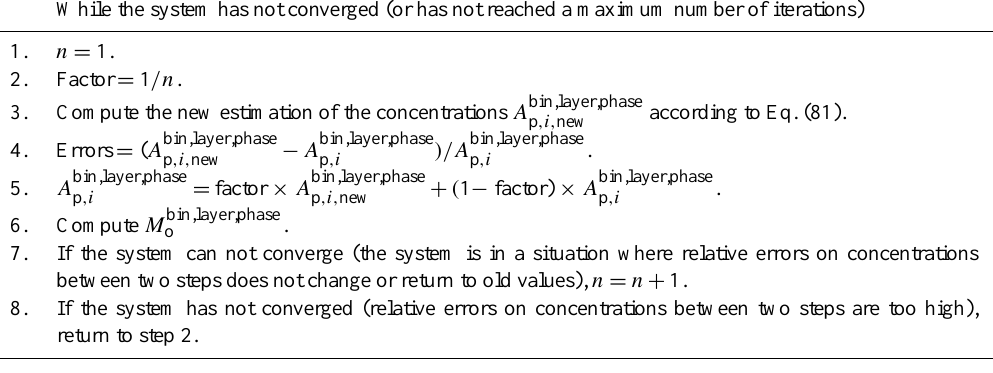
Table 1. Algorithm to compute the partitioning of compounds at equilibrium in the dynamic approach.